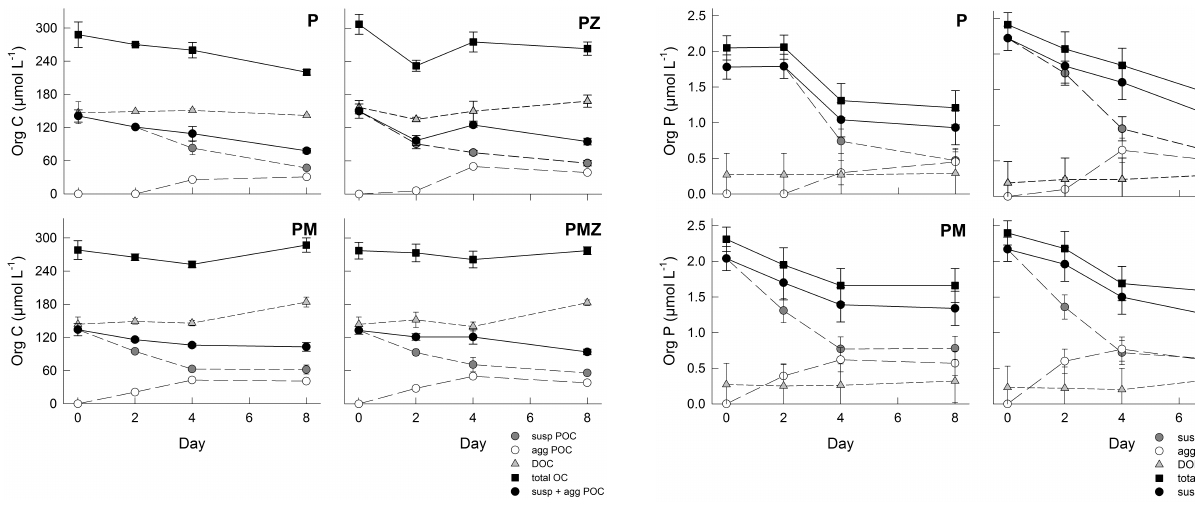
Fig. 1. Concentrations of DOC, total POC, suspended POC, and POC in aggregates in the 4 treatments during the experiment.